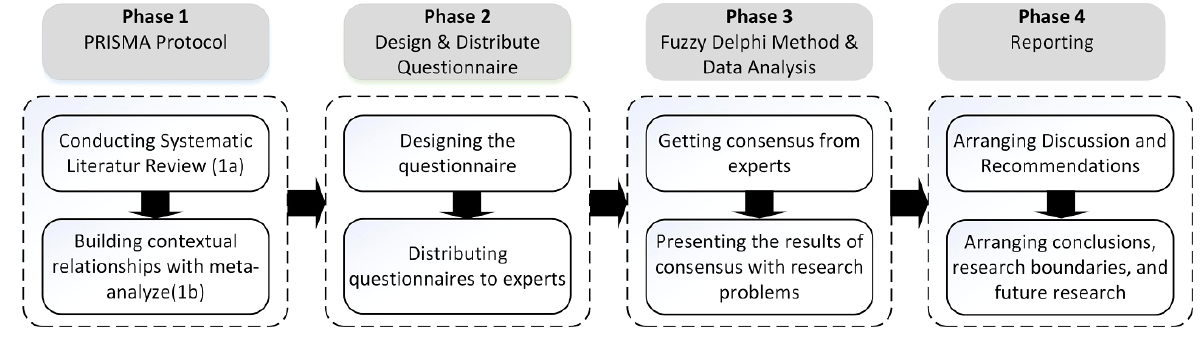
Figure 1. Overall Research Stages.